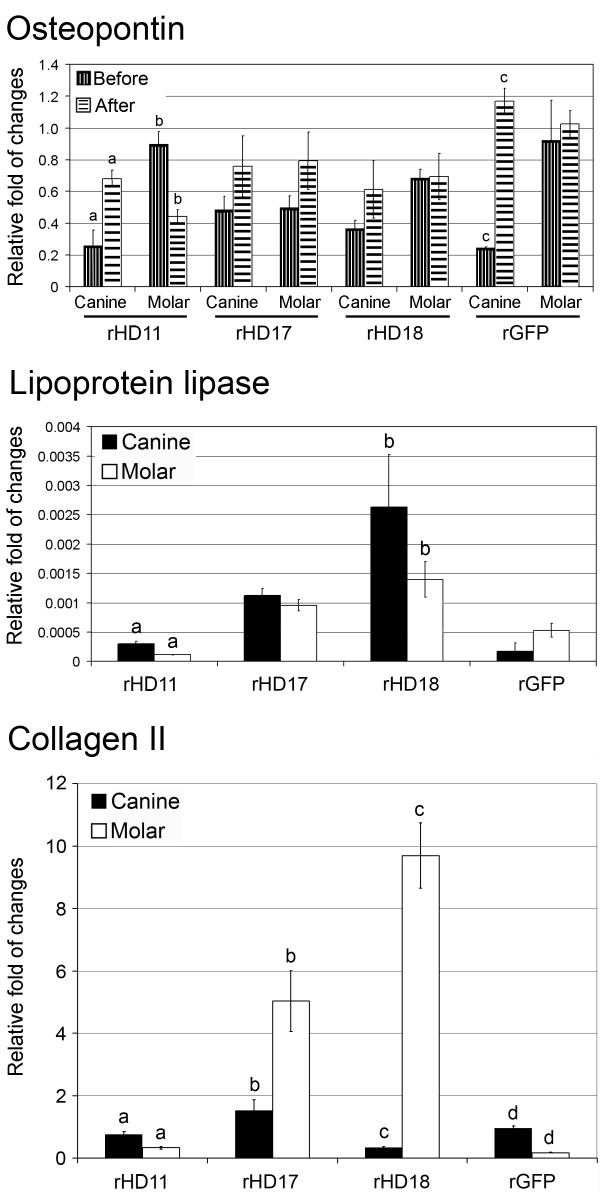
Expression of differentiation markers. Quantitative analysis of the transcripts of differentiation markers (Osteopontin, Lipoprotein lipase and Collagen II) in canine and molar of rHD/G-DPSCs and rG-DPSCs was determined by qRT-PCR. No detectable expression of lipoprotein lipase and collagen II was observed before induction of differentiation. Column shares the same alphabet are significantly different (P < 0.05). Three replicas were performed.